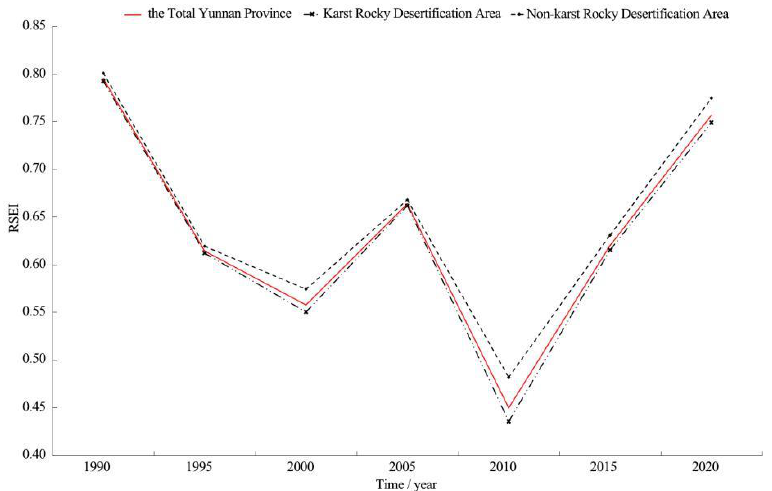
Figure 4. Statistics of changes in RSEI mean value in Yunnan Province (1990 – 2020).